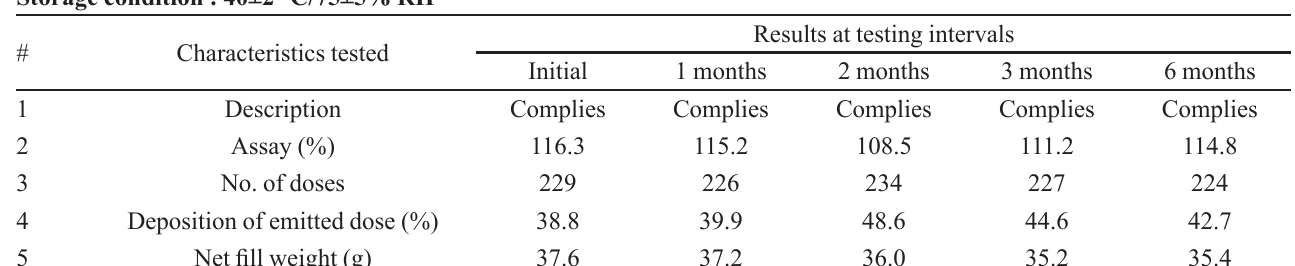
TABLE VIII - Stability data of Beclomethasone HFA based MDI 200 m g stored at 40±2 °C/75±5% RH & 25±2 °C/60±5% RH Storage condition : 40±2 °C/75±5%